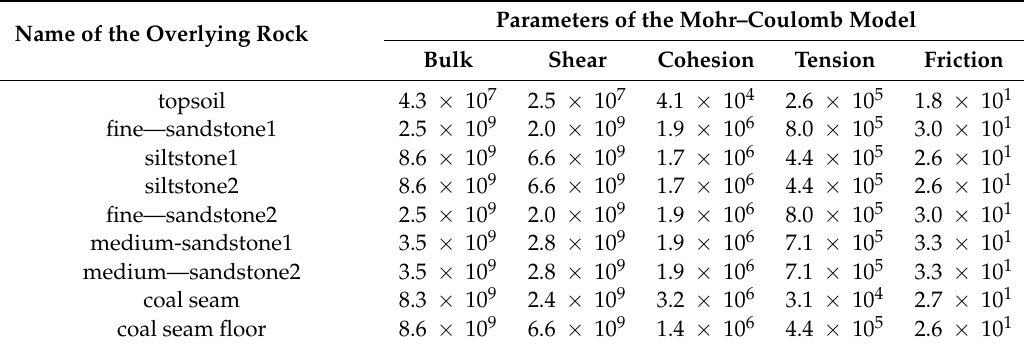
Table 1. Mechanical parameters of the numerical simulation model.